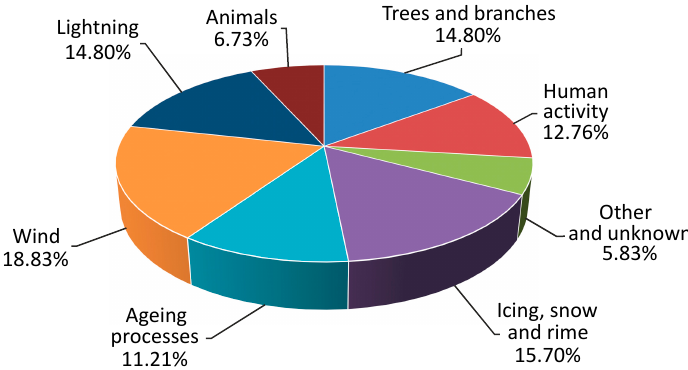
Figure 1. Percentage share of causes of 110 kV overhead line failures [4].